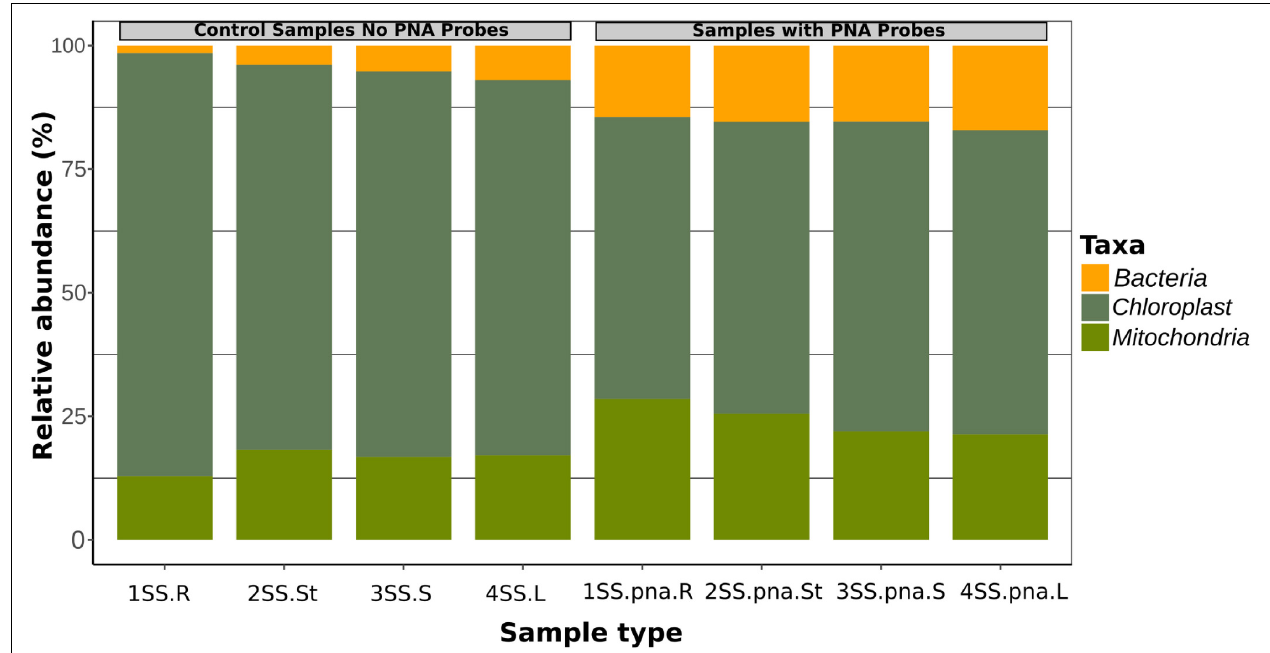
FIGURE 1 | Relative fraction of sequences belonging to Bacteria, Plastids and Mitochondria in four orchid samples, as obtained by metabarcoding of 16S rRNA genes without PNA blockers, compared with the same samples with PNA.